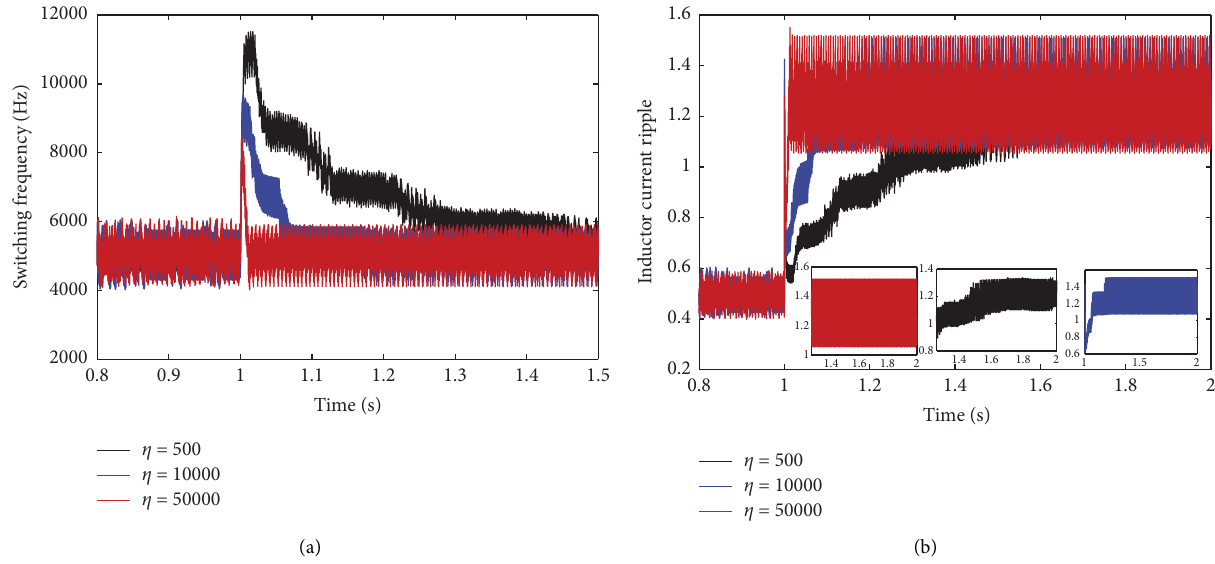
Figure 11: Te efect of the FCL integral constant to (a) the switching frequency during input voltage step change; (b) inductor current ripple during step change of input